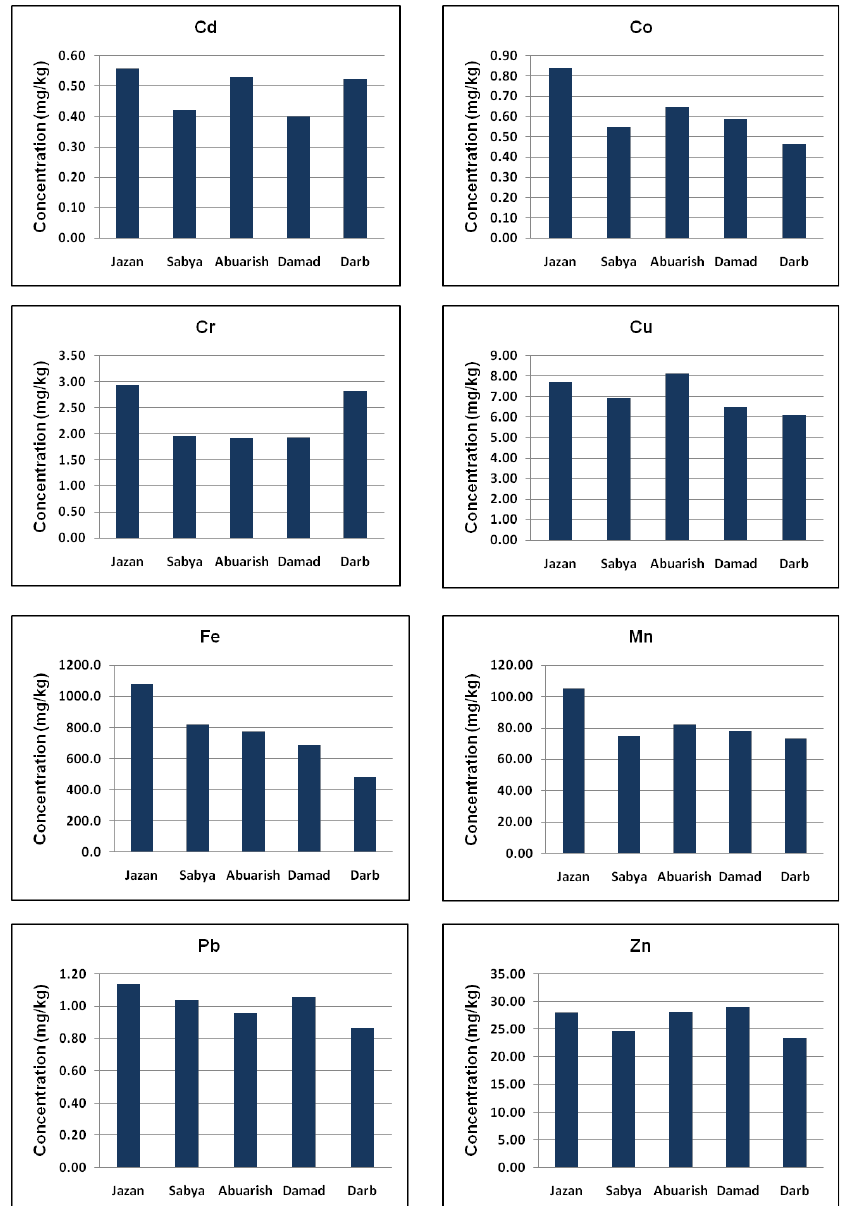
Figure 3. Location-based distribution of heavy metals within the studied region; mean concentra- tions (on dry weight basis) measured in leafy vegetables including lettuce, radish, mint, parsley and jarjir.